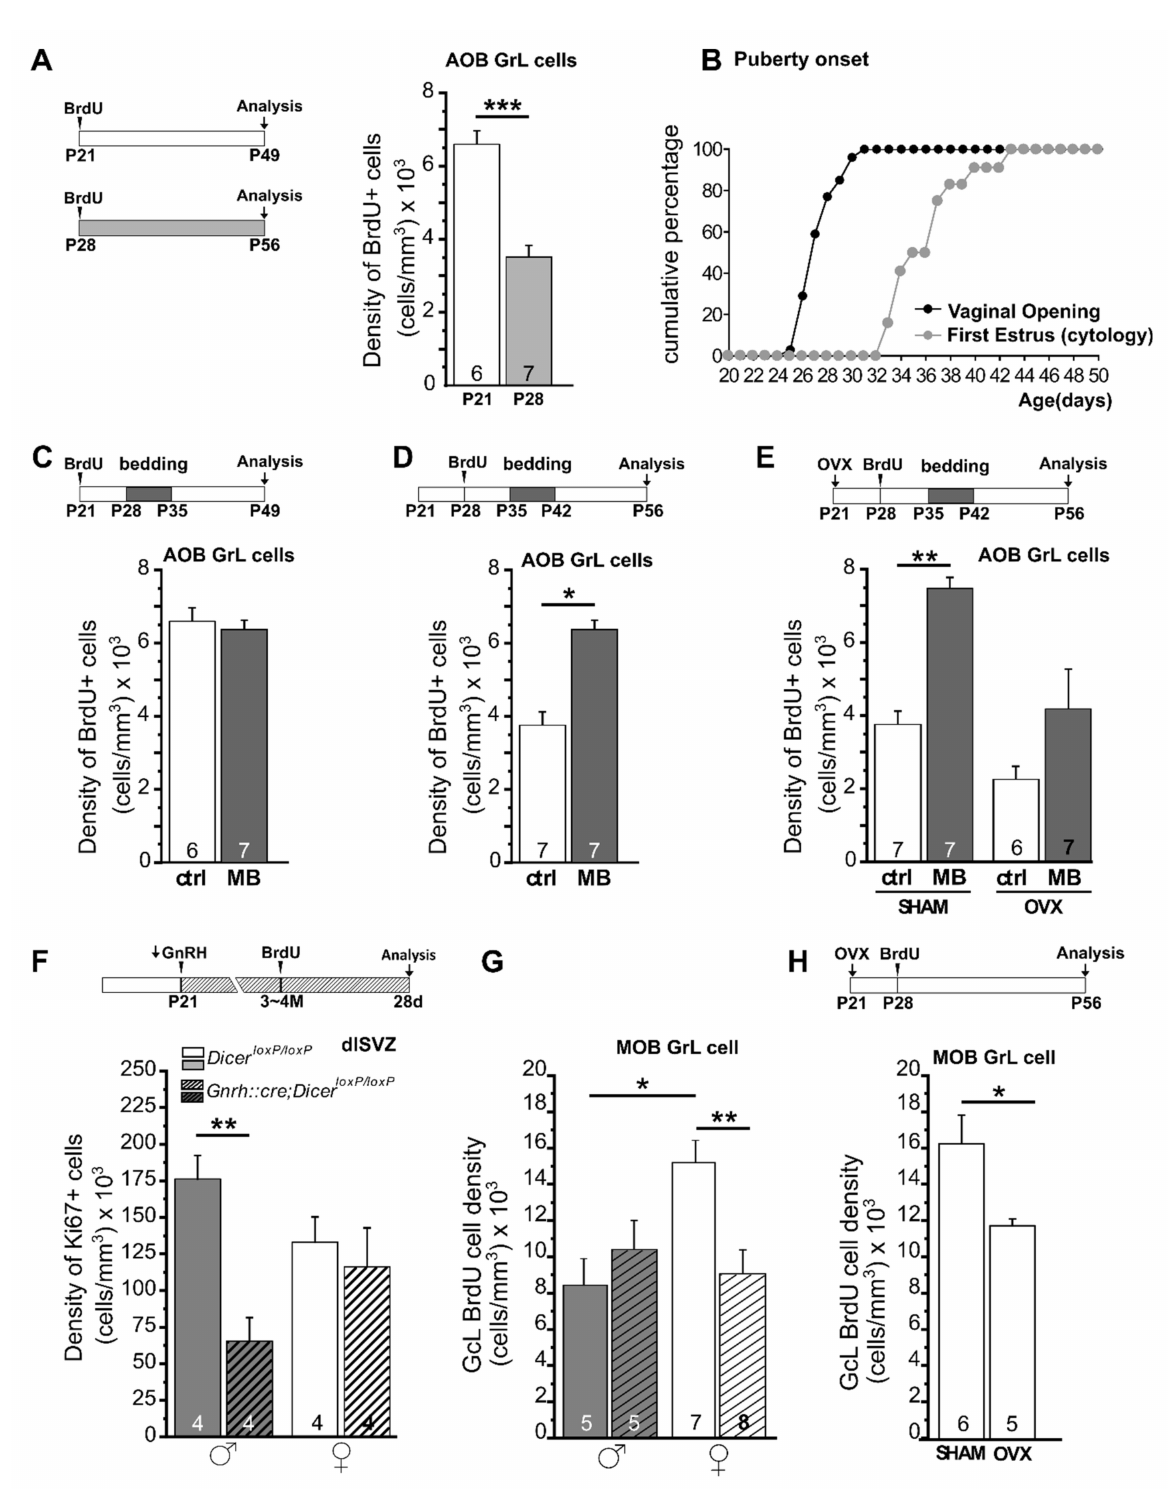
Figure 2. Time course and modulation of adult neurogenesis during peripubertal life and adulthood. ( A ) Injections of the cell birth marker BrdU before puberty (P21) results in double the number of 28-day-old newborn granule cell (GC) neurons in the AOB when compared with BrdU treatments performed after the onset of puberty (at P28) (unpaired Student’s t